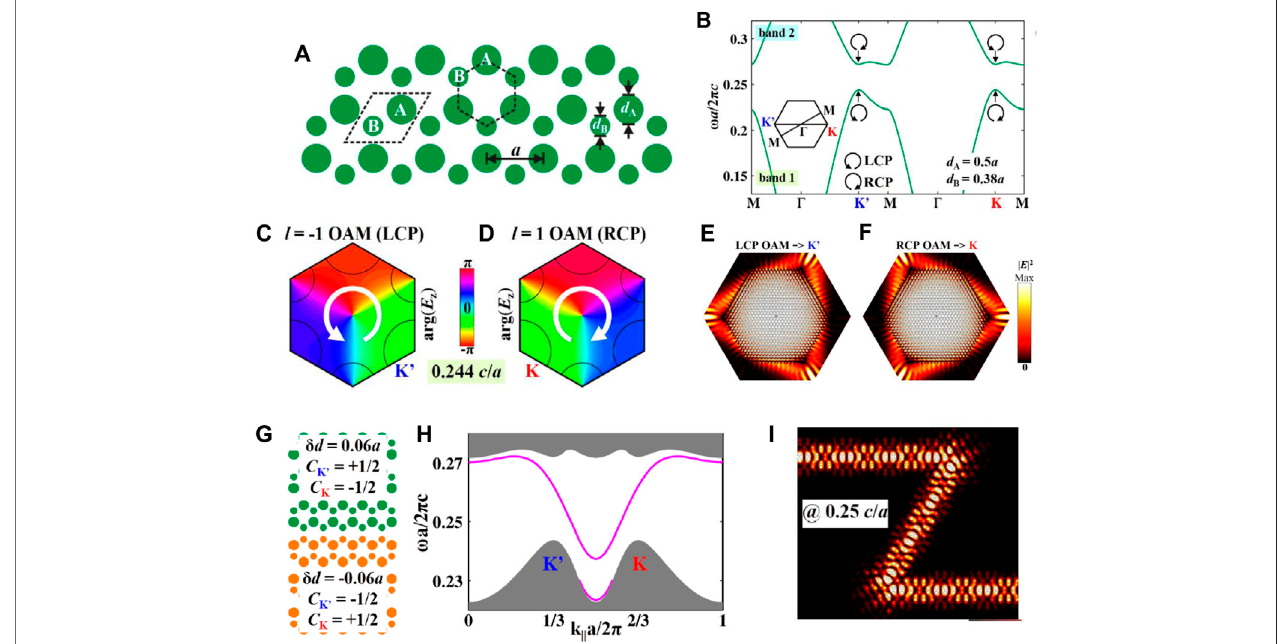
FIGURE5| PhotonicanalogofvalleyHallinsulator[119]. (A) SchematicofvalleyPhCsbasedonhoneycomblattice,wheretheradiiofthetworodsaredifferentina unit cell. (B) Photonic band structure for transverse magnetic modes, in which four valley states are marked. (C,D) Valley-contrasting chiral orbital angular momentum and the phase distributions of E z at K and K ′ valleys. (E, F) Electric intensity of the excited. (E) K ′ and (F) K valley states. (G) Schematic of the edge constructed by two distinct valley PhCs. (H) Valley-dependent edge states. (I) Electric fi eld intensity at a speci fi c frequency, illustrating the smooth propagating wave through the Z sharp corners. Reproduced permission from Ref.